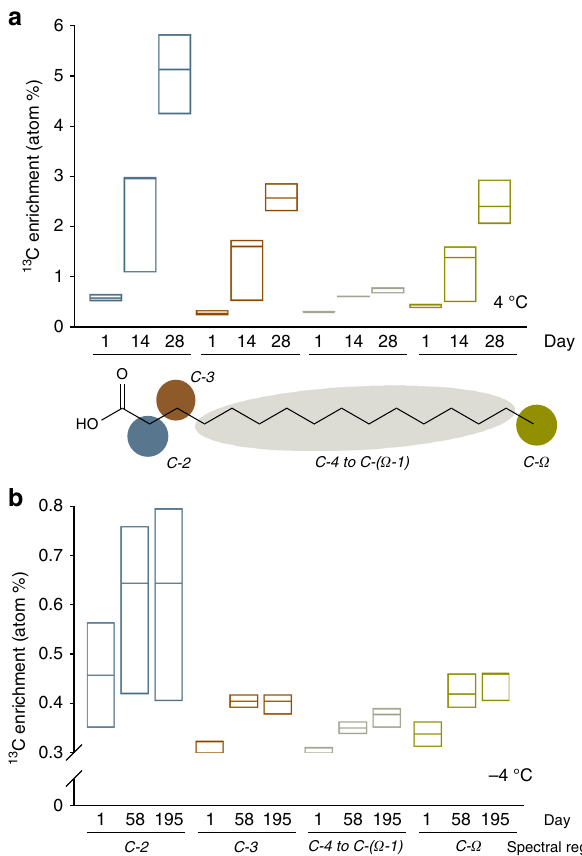
Fig. 3 13 C from the added 13 C-cellulose was used to synthetize new cell membrane lipids in both unfrozen and frozen soil samples. Incorporation of the 13 C label into cell membrane lipids as determined by 1D 1 H analysis and a 1D variant of a 1 H, 13 C Heteronuclear Single Quantum Coherence NMR spectroscopy, in incubations at 4 °C (panel a ) and − 4 °C (panel b ). The bars show the median contents and max and min ranges of 13 C- enrichments (relative to natural abundance) in acyl chains at the start (day 1), mid-point (days 14 and 58 at 4 and − 4 °C, respectively) and end (days 28 and 195 at 4 and − 4 °C, respectively) of the incubations. We obtained signals for spectral regions assigned to the following hydrogen and corresponding C atoms (illustrated in the model phospholipid fatty acid chain): 2.28 p.p.m.-H-2 (blue circle and bars); 1.62 p.p.m.-H-3 (brown circle and bars); 1.28 p.p.m.-H-4 to H-( Ω -1) (gray elipse and bars) and 0.9 p.p.m.- H- Ω (green circle and bars). Differences in levels of 13 C-labeling between the start and the end of the incubation were examined with a Kruskal – Wallis test, which does not assume normality of